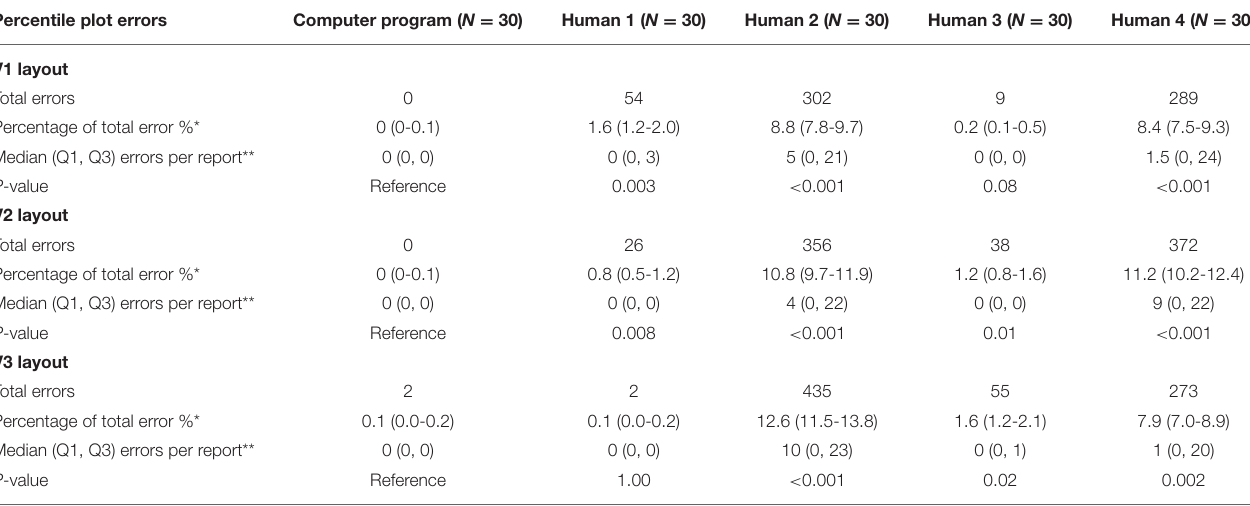
TABLE 5 | Comparison between computer program and human on percentile plot extraction errors.